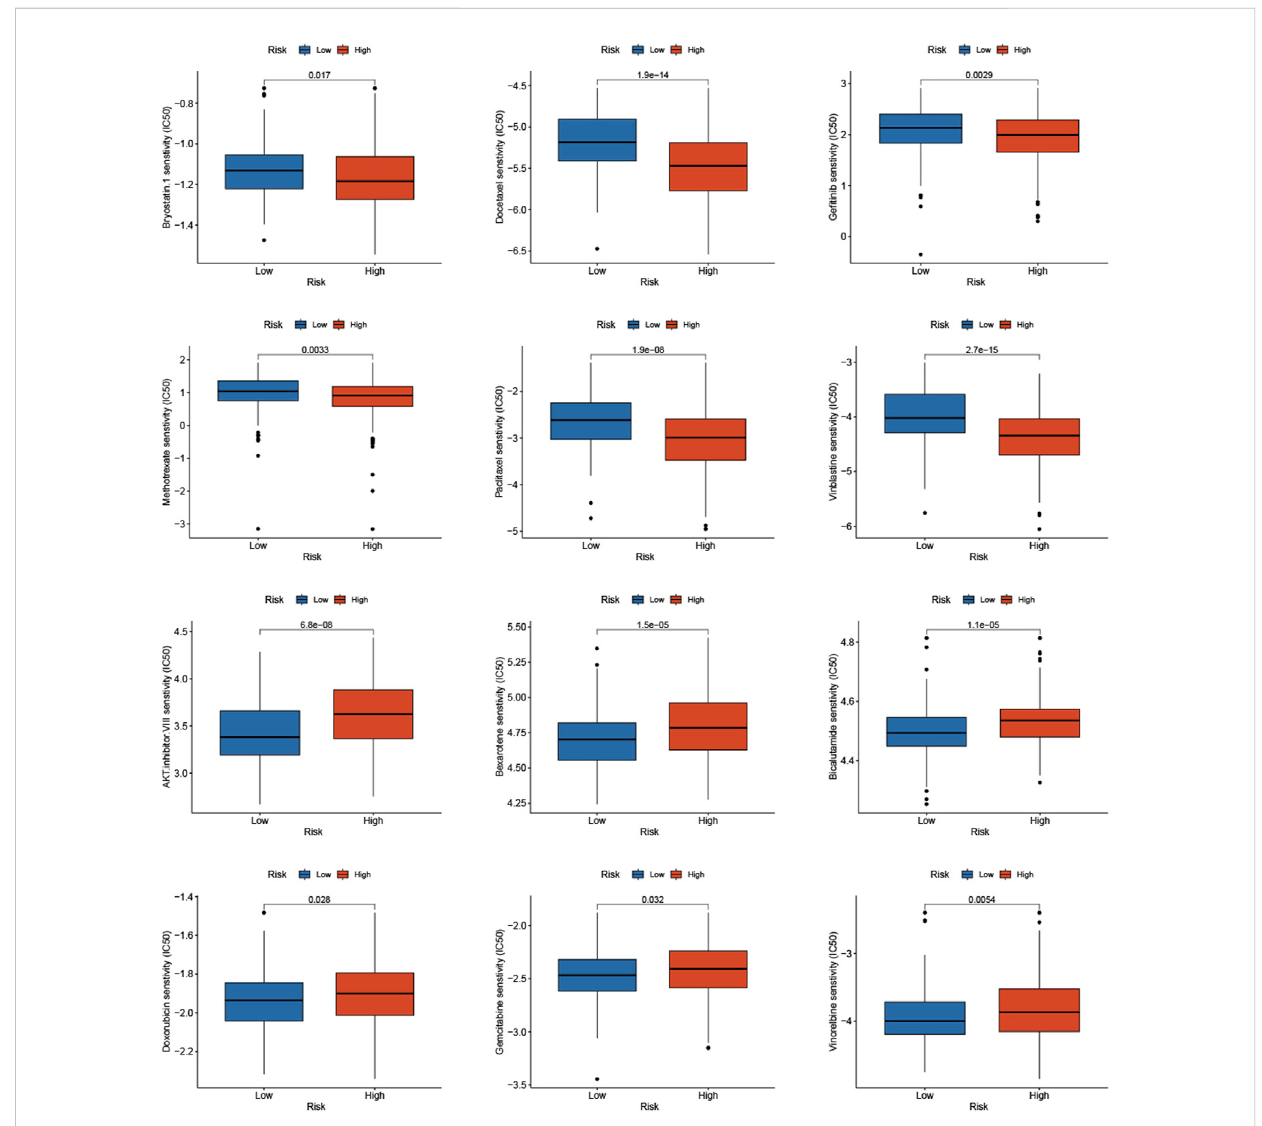
FIGURE 10 Prediction of the sensitivity to chemotherapeutic drug with the risk score by IC50